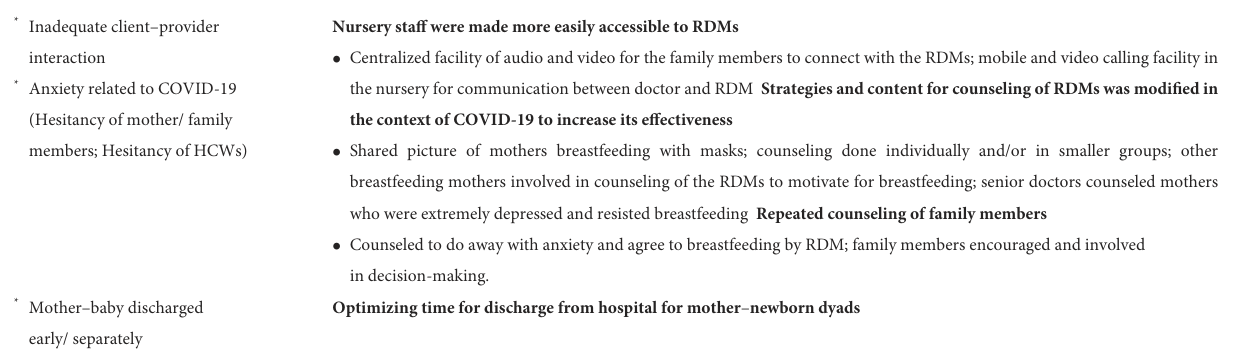
TABLE 4 Barriers experienced, and counter measures undertaken to ensure optimal breastfeeding among institutionalized mothers during COVID-19 pandemic. Perceived